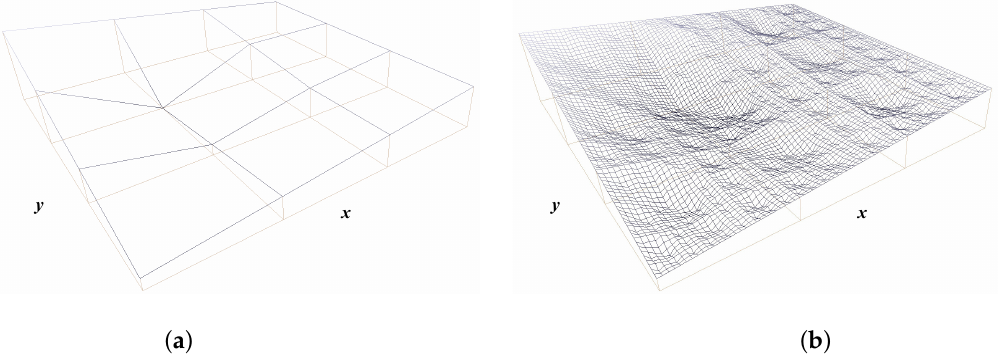
Figure 5. ( a ) The surface constructed with the original set of data. ( b ) The fractal interpolation